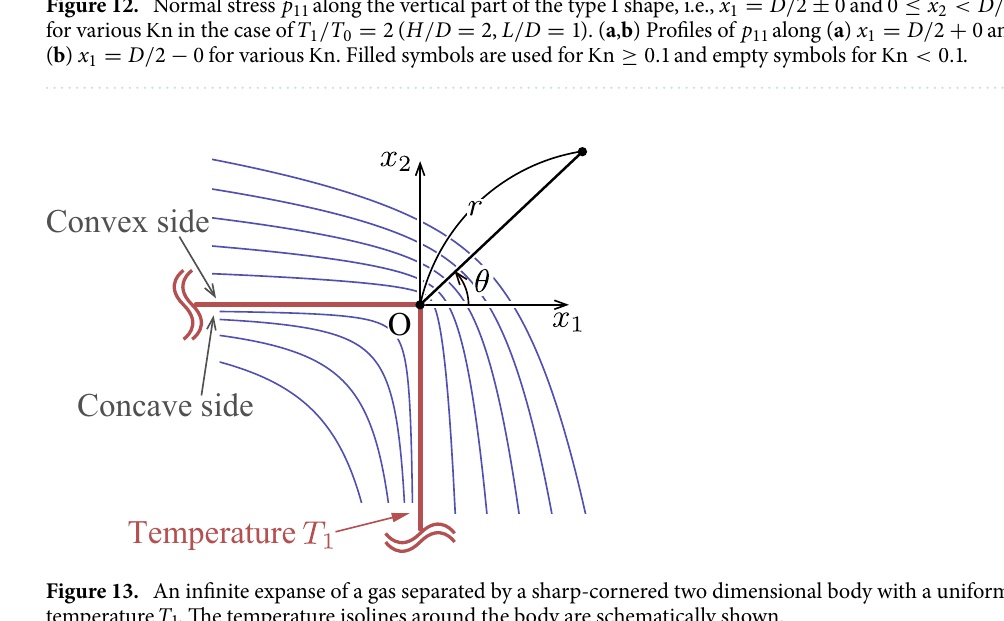
Figure 13. An infinite expanse of a gas separated by a sharp-cornered two dimensional body with a uniform temperature T 1 . The temperature isolines around the body are schematically